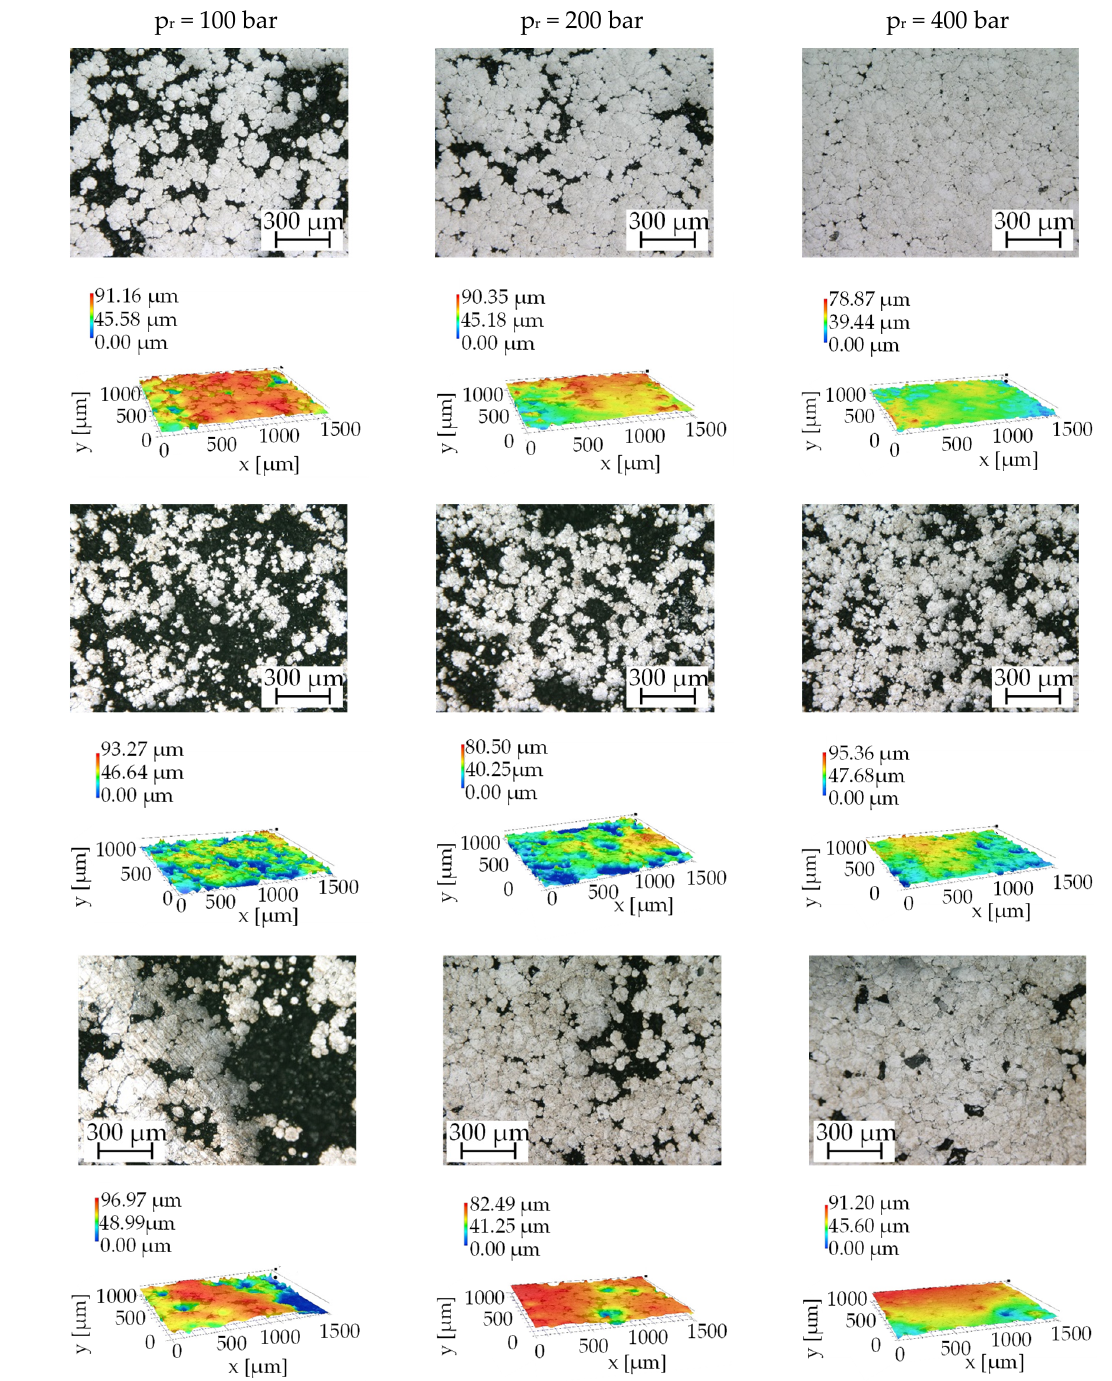
Figure 8. Influencing the surface topography (top view and false-color images) of cold sprayed specimens with the aid of deep rolling.